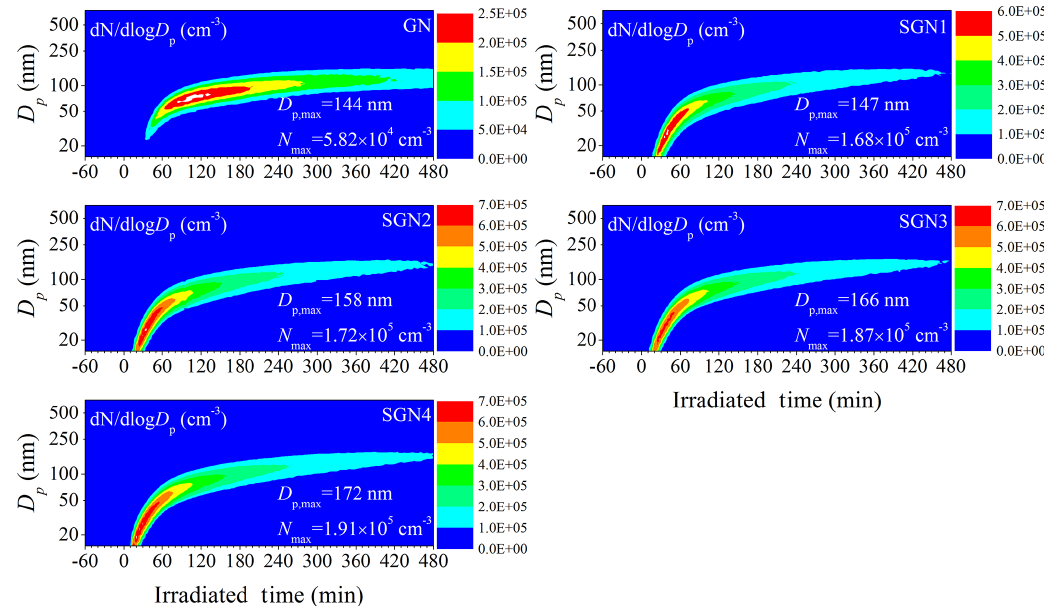
Figure 3. Time series of the size distributions for the generated secondary aerosol during the photo-oxidation experiments with different SO 2 initial concentrations (Exps. GN, SGN1, SGN2, SGN3, and SGN4). D p , max and N max represent the maximal diameter and number concentration of generated secondary aerosol, respectively, during each photo-oxidation